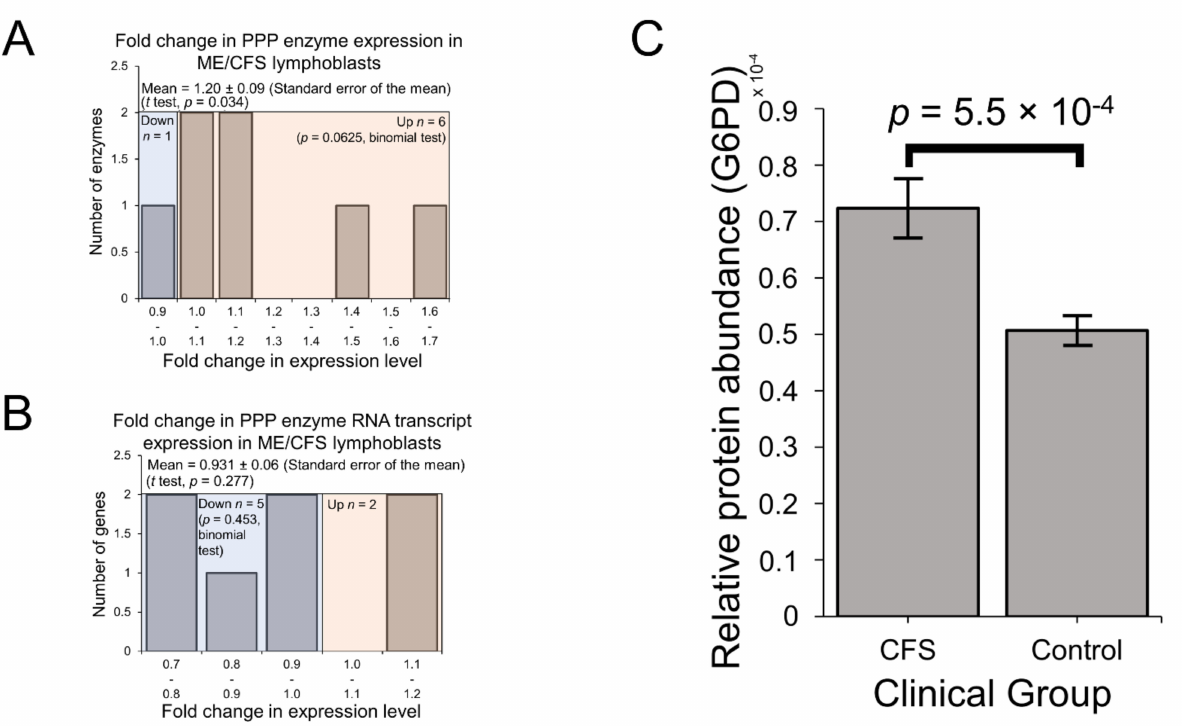
Figure 4. Expression of the pentose phosphate pathway (PPP) is upregulated at the protein level in Myalgic Encephalomyeli- tis (ME/CFS) lymphoblasts. Error bars represent the standard error of the mean. Mass spectrometry proteomics experiment: ME/CFS n = 34, control n = 31. Each cell line was sampled once, or twice for a subset of healthy controls arbitrarily selected to act an internal control between experiments. ( A ) A total of 7 PPP enzymes were detected within the whole-cell proteomes of lymphoblasts from ME/CFS and control lymphoblasts. Fold change refers to the mean abundance of a given protein in the CFS group divided by the mean abundance in the control group. There was no significant difference in the proportion of upregulated PPP enzymes (binomial test with H o set to 0.5), but the magnitude of upregulation was significantly elevated in ME/CFS lymphoblasts (single-sample t test with H o m ≤ 1 and H 1 m>1, p = 0.034). ( B ) A total of 7 RNA transcripts encoding PPP enzymes were detected by RNA sequencing within the whole-cell transcriptomes of ME/CFS and control lymphoblasts. Mean fold change was calculated for the ME/CFS group versus the control average for each transcript. The proportions of reduced or elevated transcripts were not significantly different (binomial test with H o set to 0.5) nor was the average magnitude of expression (single-sample t test with H o m = 1). ( C ) The expression level of G6PD is significantly elevated ( t test, p = 5.5 × 10 − 4 ) in whole-cell mass spectrometry proteomics experiments (independent t test ). Relative abundance was obtained from Intensity-Based Absolute Quantitation values normalised to the control average within the respective individual